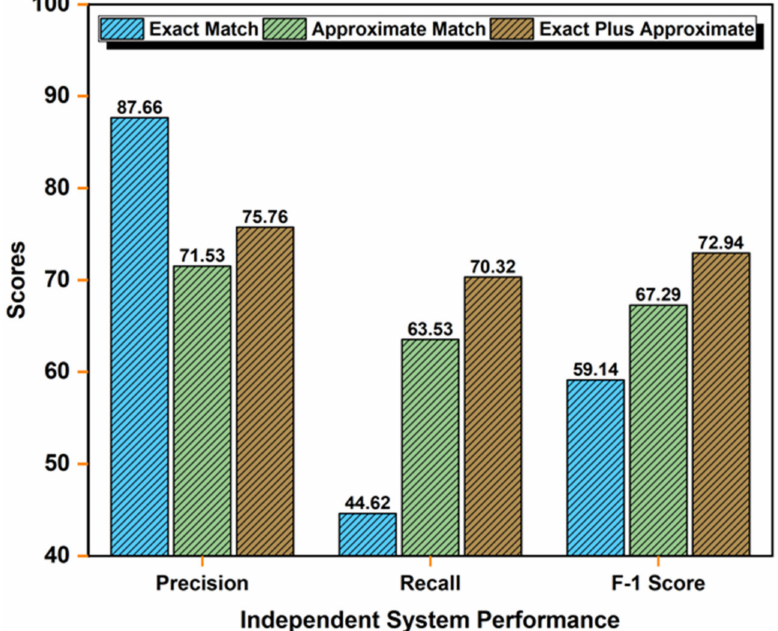
Figure 8. Individual system performance for exact, approximate, and exact-plus-approximate term matching to UMLS